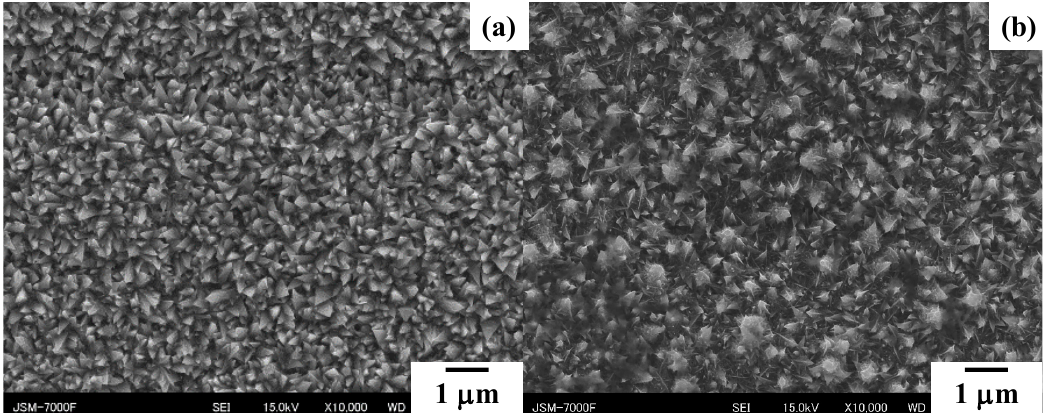
Figure 6. Comparison of SEM images on the growing acicular microtextures with the duration during the wet-plating process. ( a ) τ = 210 s and ( b ) τ = 630 s.